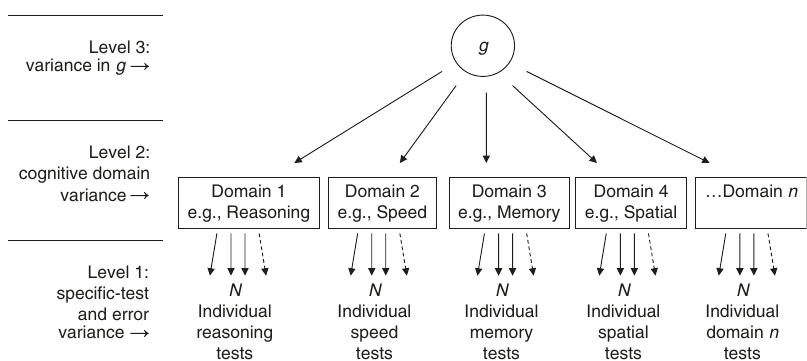
Fig. 1 The hierarchical model of cognitive function variance. At level 1, individuals differ in speci fi c tests that assess the various cognitive domains. Scores on all the tests correlate positively. It is found that there are especially strong correlations among the tests of the same domain, so a latent trait at the domain level can be extracted to represent this common variance. It is then found that individuals who do well in one domain also tend to do well in the other domains, so a general cognitive latent trait called g can be extracted. This model allows researchers to partition cognitive performance variance into these different levels. They can then explore the causes and consequences of variance at different levels of cognitive speci fi city-generality. For example, there are genetic and ageing effects on g and on some speci fi c domains, such as memory and speed of processing. Note that the speci fi c-test-level variance contains variation in the performance of skills that are speci fi c to the individual test and also contains error variance. (Reproduced, with permission, from ref. 3